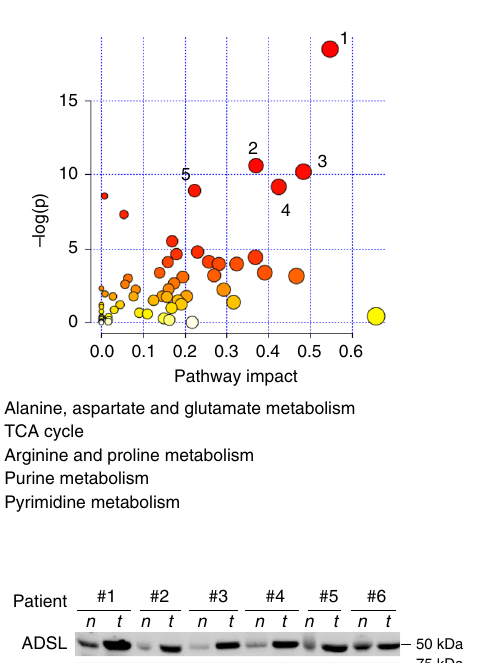
scores500 750 Rank in ordered Ranking metric